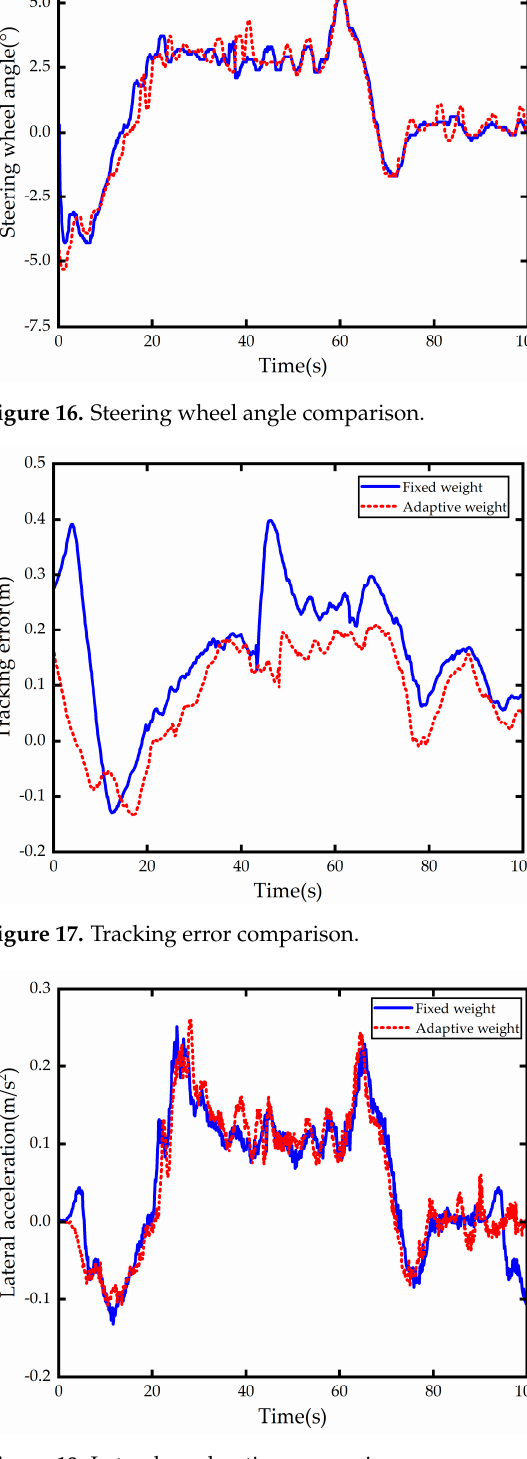
Figure 18. Lateral acceleration comparison.